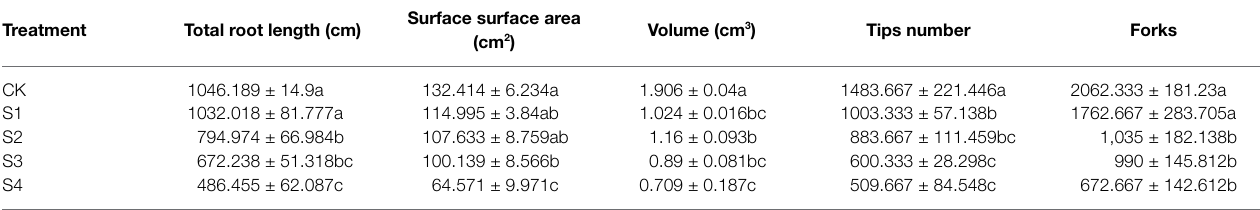
TABLE 2 | The root parameters affected by salinity in tomato plants.